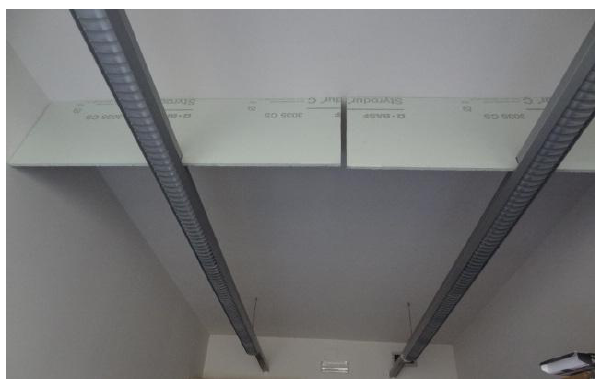
Figure 10. Image of the corrective ambient actuation.